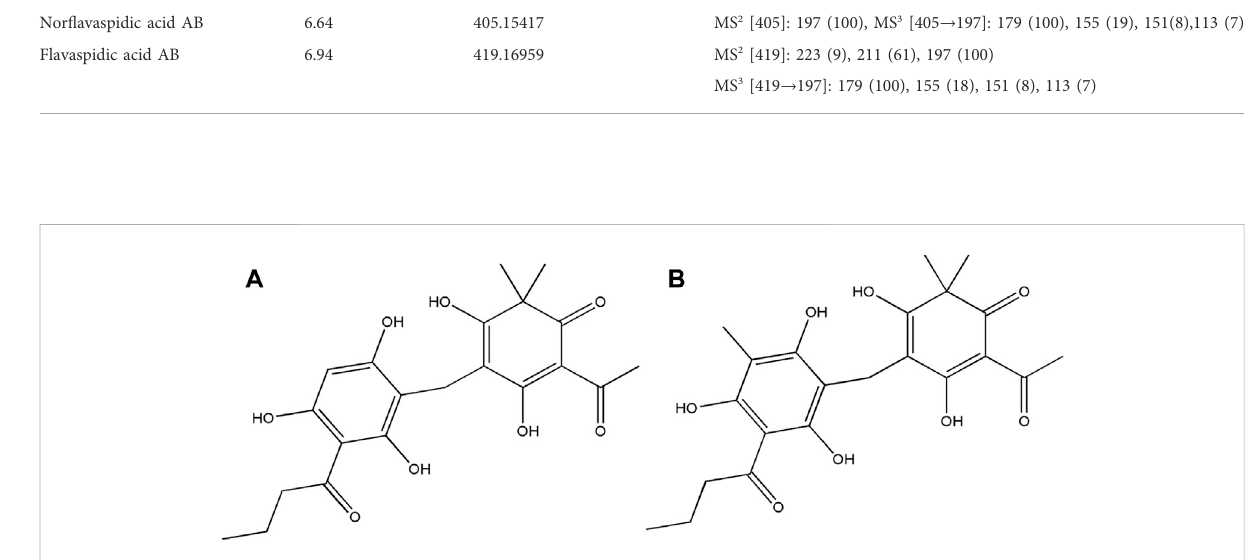
FIGURE 2 Structures of the bioactive natural products isolated from D. crassirhizoma . (A) Nor fl avaspidic acid AB and (B) fl avaspidic acid.